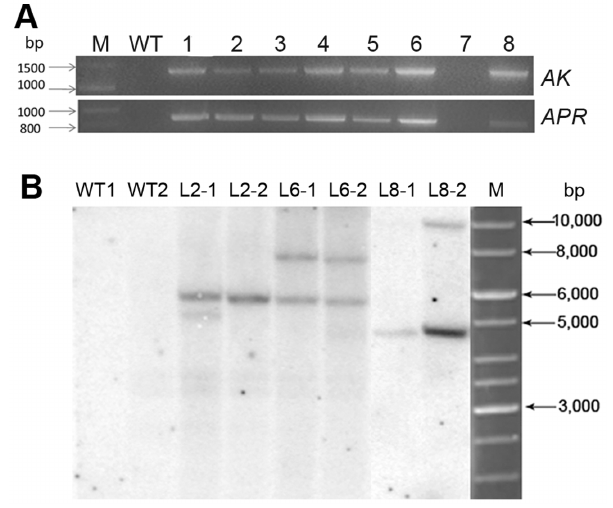
Figure 2. PCR and Southern blot analysis of transgenic alfalfa plants. A. PCR analysis of AK and APR genes in the transgenic alfalfa plants. Lane WT: wild-type line; Lane1-6: Line1-6 transgenic alfalfa lines; Lane 7: water; Lane 8: pDESAK-APR vector; Lane M: GeneRuler TM 1kb DNA ladder (MBI Fermentas, Maryland, USA). Arrows on the left indicate the standard marker bands: 800 bp, 1,000 bp and 1,500 bp. B. Southern blot analysis of AK and APR genes in the transgenic alfalfa plants. Lane L2-1,L2-2,L6-1,L6-2,L8-1,L8-2: two replicates of each transgenic line (Line 2, Line 6, Line 8), Lane WT: wild-type line. M: M: GeneRuler TM 1 kb DNA ladder. Arrows on the right indicate the standard marker bands: 3,000 bp, 5,000 bp, 6,000 bp, 8,000 and 10,000 bp.